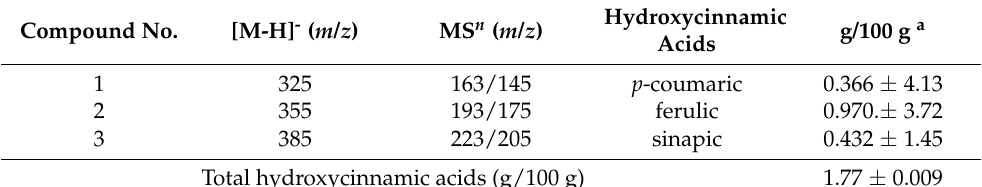
Table 3. Identification and concentration values of hydroxycinnamic acids in RLE. Compound